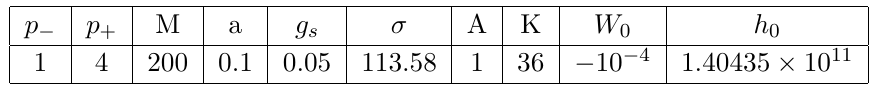
Table 2. Parameters used to compute the cosmological constant in the KKLT